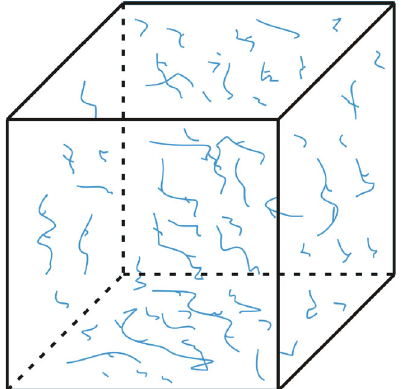
Figure 1: Schematic of naturally fractured reservoir.